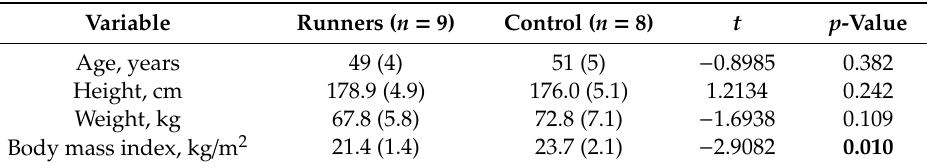
Table 1. On average, runners had been running 82.6 (27.9) km / week for 23 (SD: 13, range: 10–39) years. Table 1. Descriptive statistics of runners ( n = 10) and controls ( n = 9).